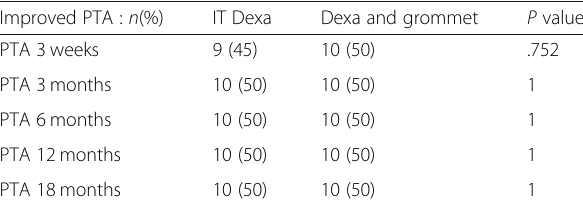
Table 4 Comparing Dexa through Grommet and saline through